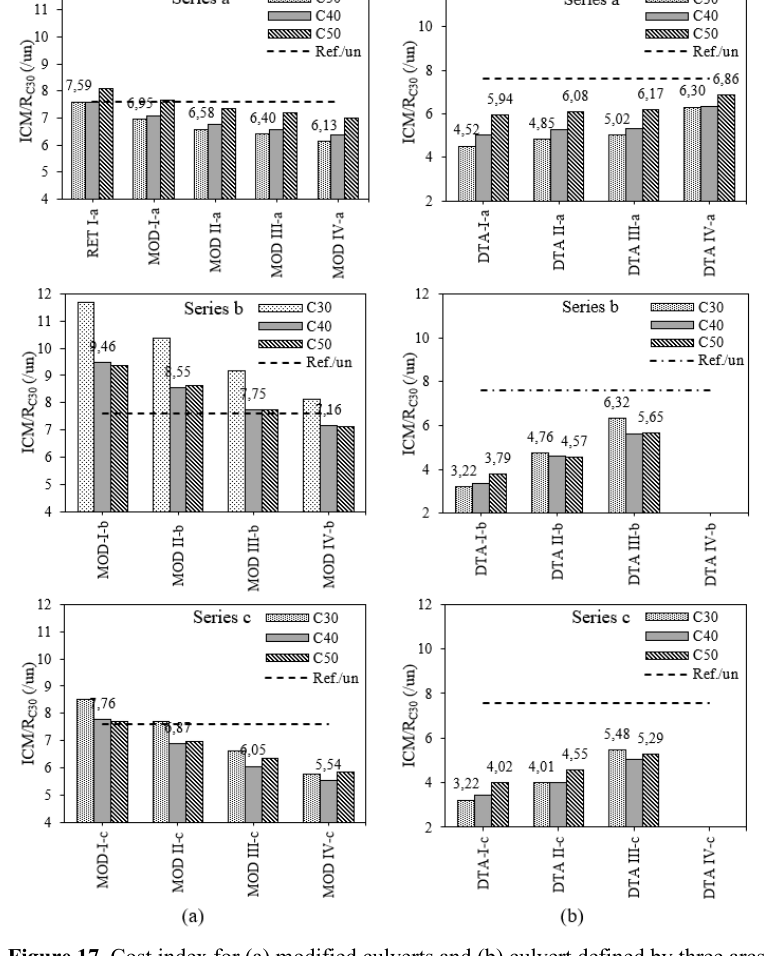
Figure 17. Cost index for (a) modified culverts and (b) culvert defined by three